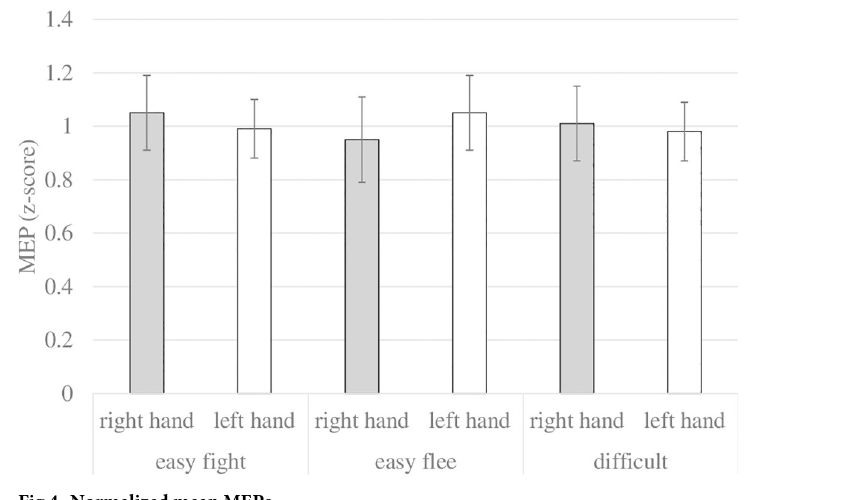
Fig 4. Normalized mean